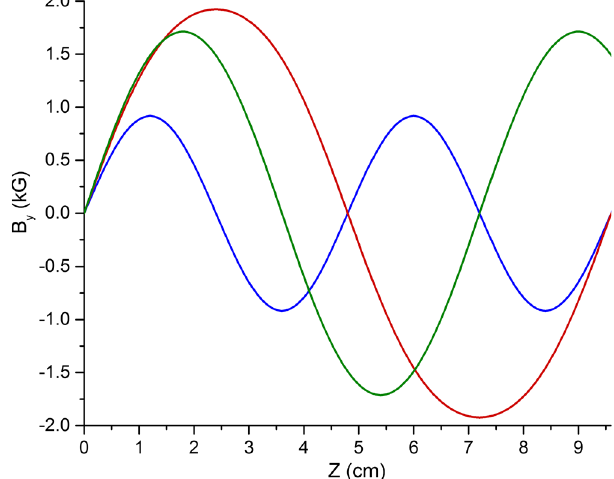
FIG. 8. Field distribution in undulator (blue line: 4.8 cm period, green line: 7.2 cm period, red line: 9.6 cm period).